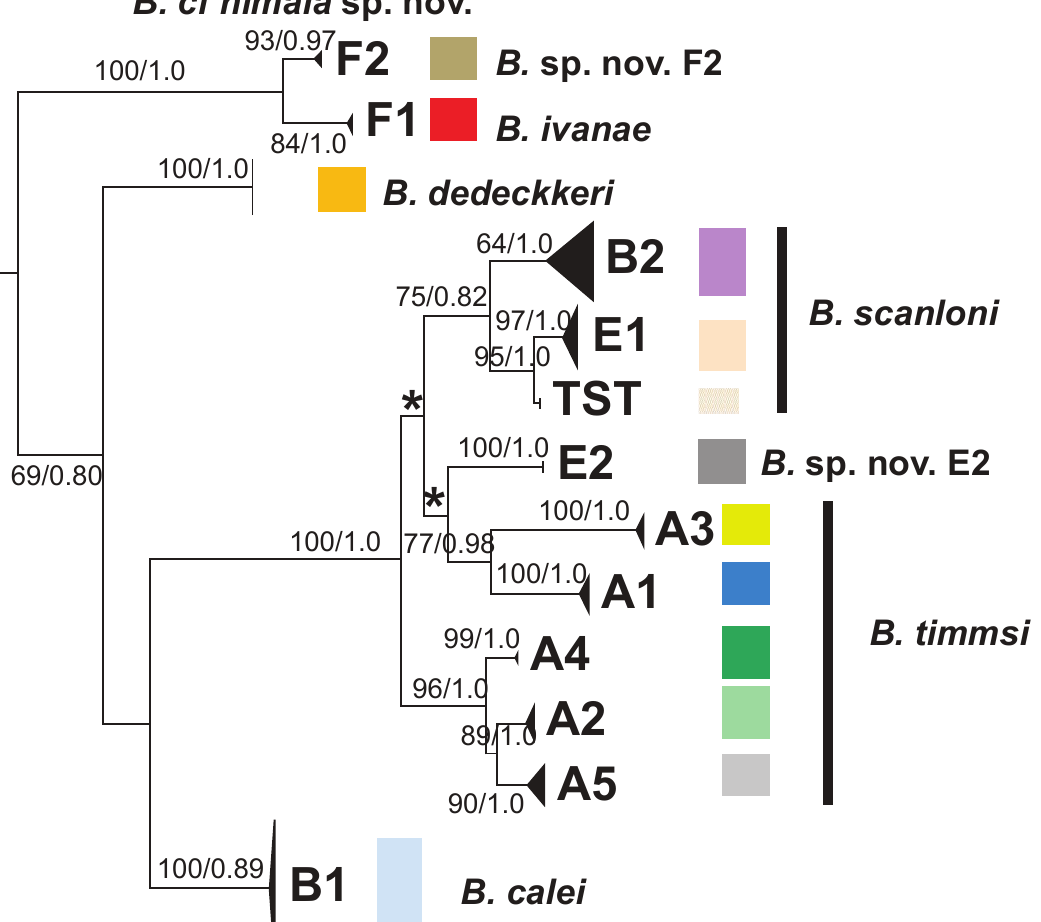
Fig. 2. Phylogenetic tree constructed with Bayesian Inference (BI) and Maximum likelihood (Ml) methods from cOI sequences of 99 ostracods from the Bennelongia barangaroo lineage and with B. nimala as outgroup. numbers above nodes illustrate statistical support for this particular node. numbers before the hash (/) are % bootstrap values of ML analyses with 1000 replicates, numbers after the hash (/) are Bayesian posterior probabilities (ranging from 0 to 1). Both methods, BI and Ml, resulted in the same tree topology. Different phylogenetic clades are indicated by different colours (as in Fig. 3, page 15). The asterisks indicate two nodes (α1 and α2) that are weakly supported (see Discussion, p.